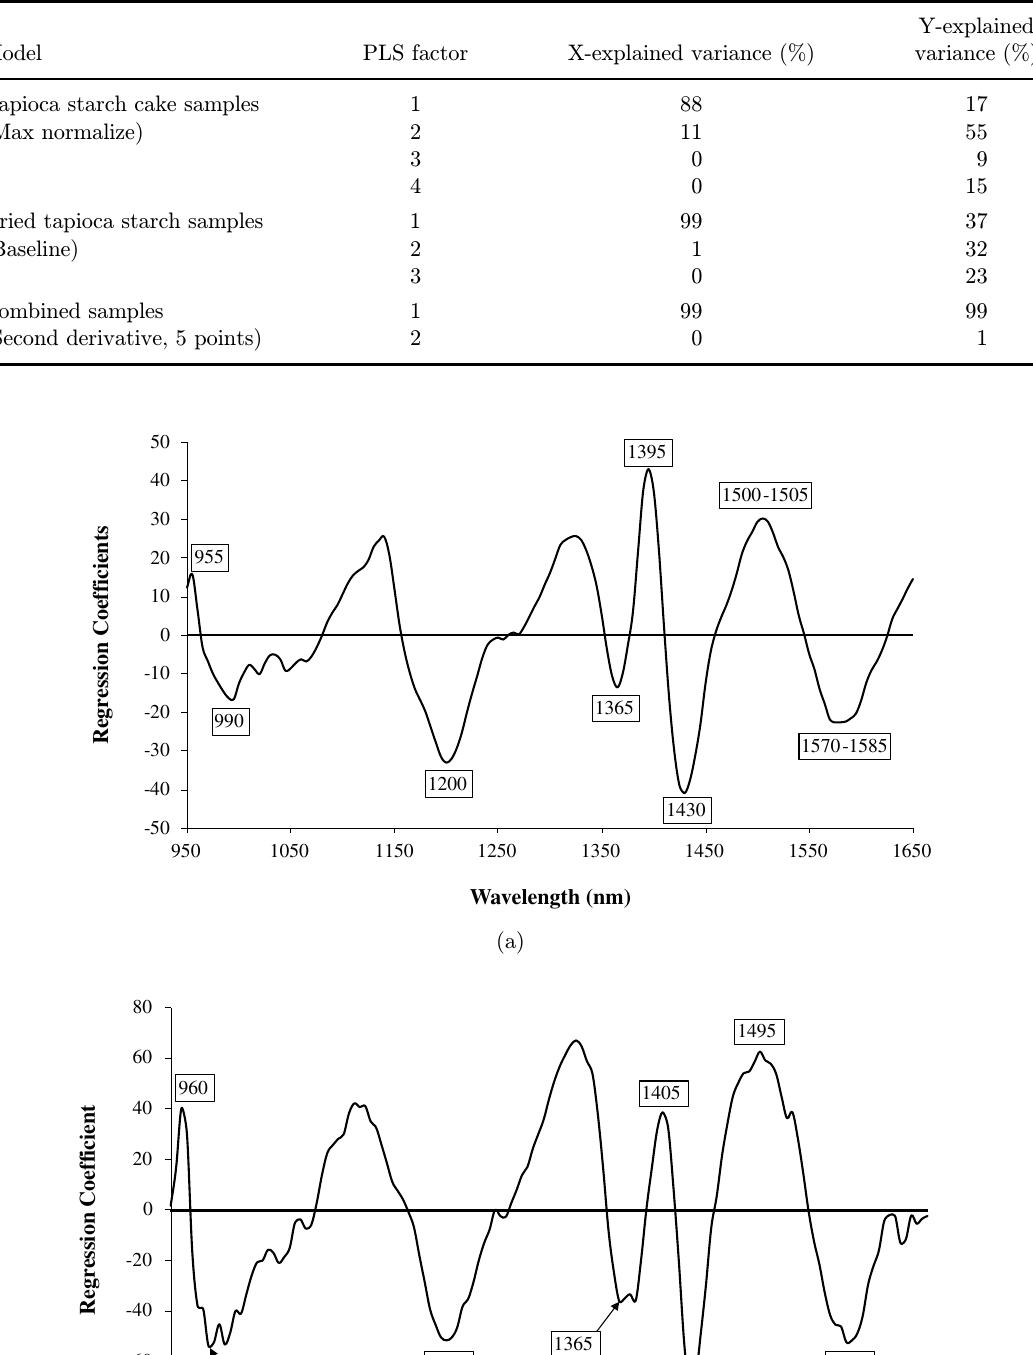
Table 2. X (NIR spectra) and Y (Moisture) explained variance for tapioca starch moisture content models.